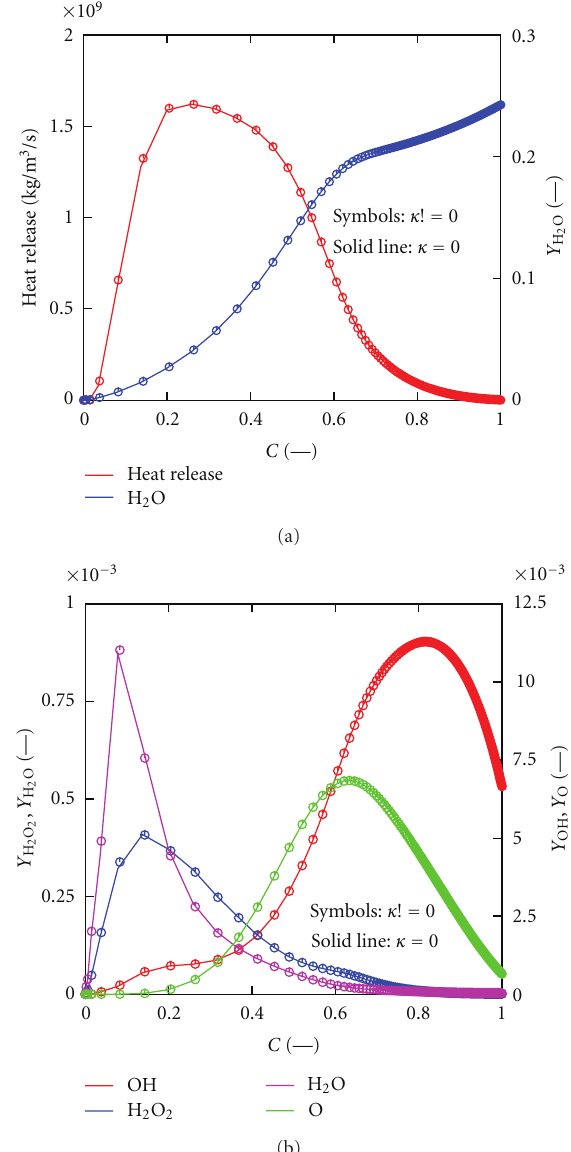
flame with (circle points) and without (solid line) volume viscosity in the reaction progress variable space, showing the (a) heat release rate and H 2 O mass fraction and (b) HO 2 , H 2 O 2 , O, and OH radicals at t = 1 . 0